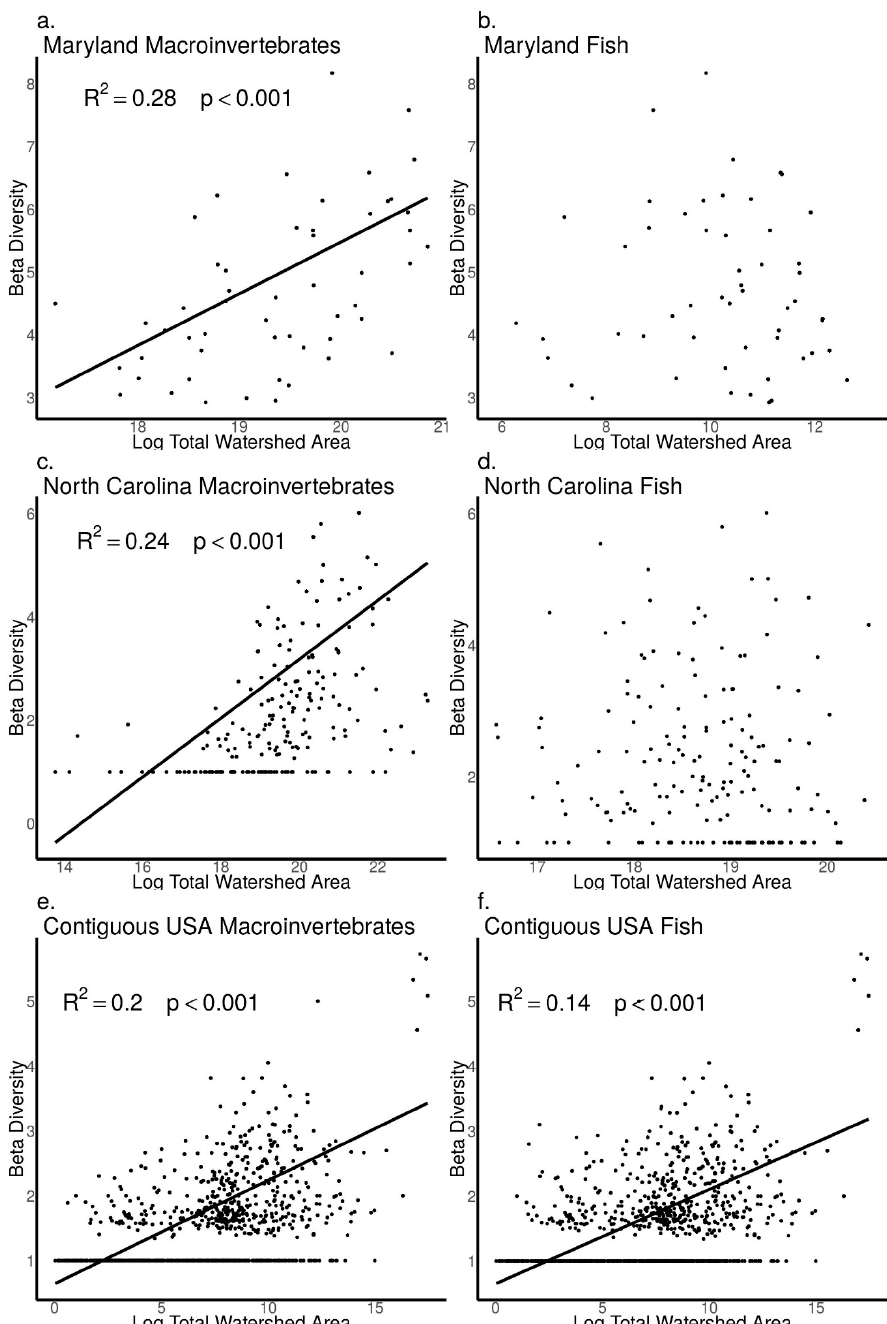
Figure 9. Relationship between beta diversity and watershed area (log transformed) for macroinvertebrate ( a , c , e ) and fish ( b , d , f ) communities collected from Maryland (MBSS), North Carolina (NCBMP) and contiguous USA (USEPA). Lines, R 2 and p -values indicate significant positive relationships determined by linear models.